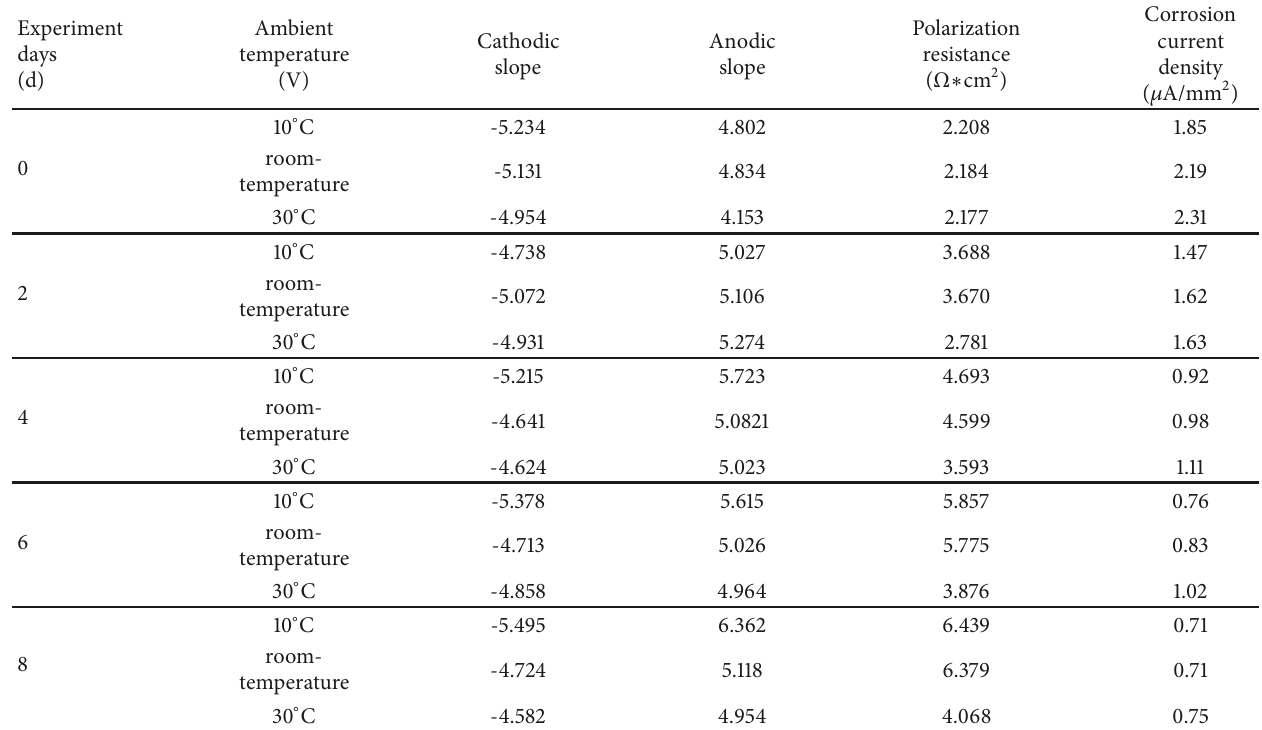
Table 4: The corrosion electrochemical parameters of the anode at different ambient temperature. Experiment